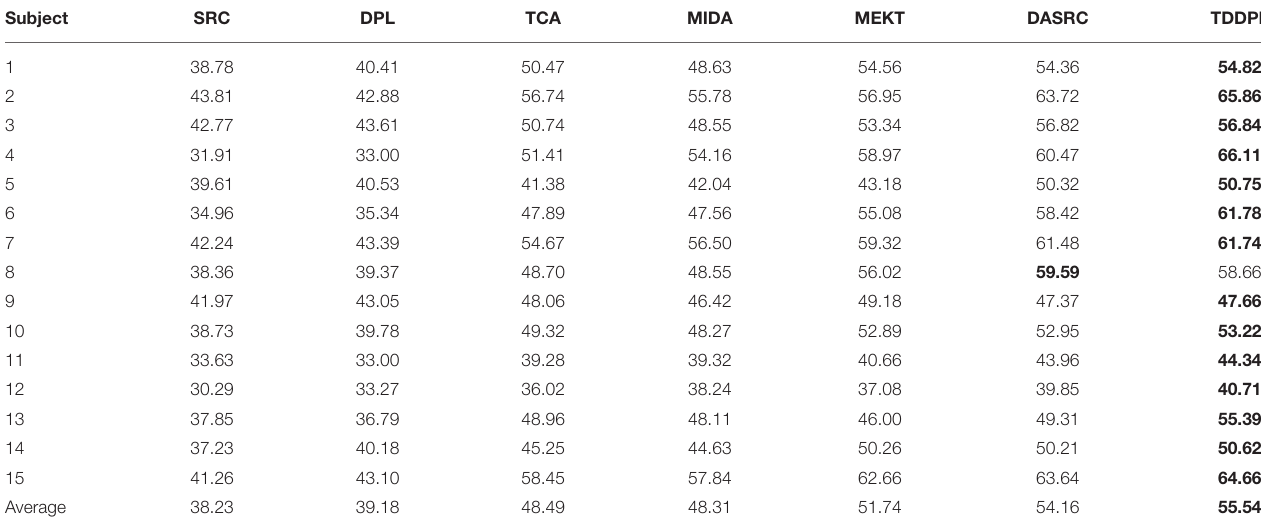
TABLE 4 | Average classification accuracies on session 1 of SEED IV dataset in the o → o scenario.